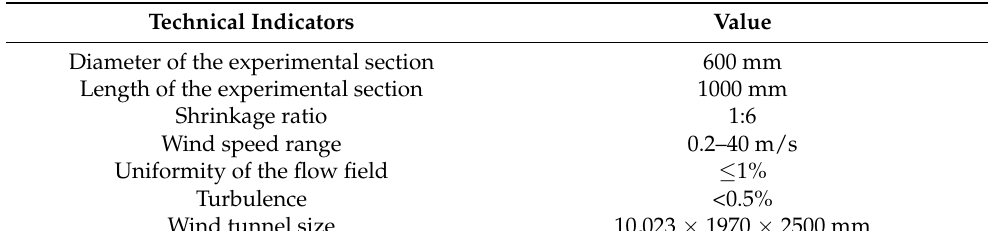
Table 1. Wind tunnel technical specifications.